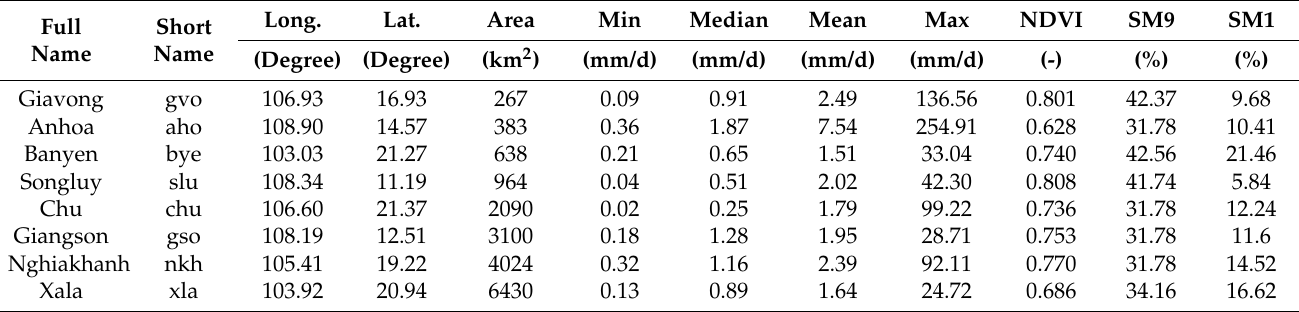
Table 2. Description of hydrological stations used in this study. Average runoff characteristics in each catchment (min, median, mean, max) are based on time series 2013–2019. NDVI is the average NDVI value for each catchment during 2017–2019 extracted from MODIS MOD13Q1 250 m product. SM9 and SM1 stand for the percentage of available SMAP 9 km and downscaled SMAP 1 km during the data assimilation period (2017–2019),